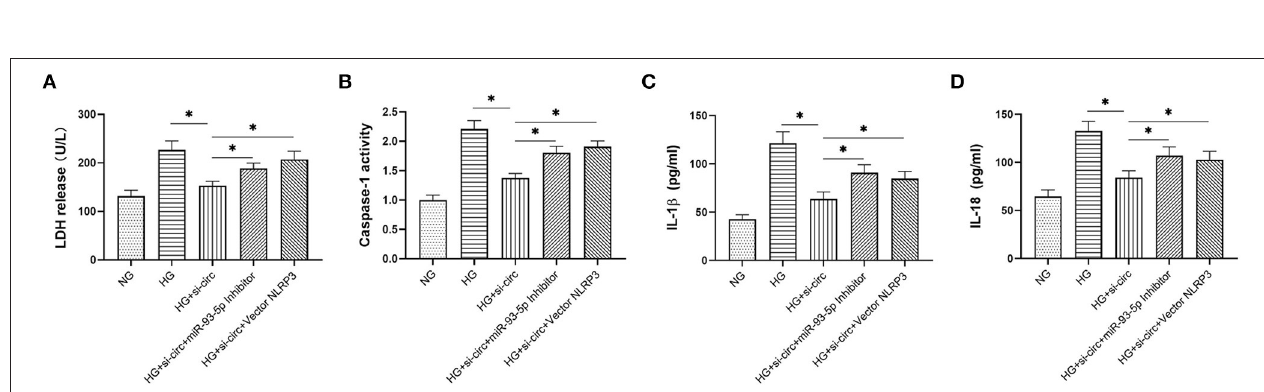
FIGURE 5 | The circ_0004951/miR-93-5p/ NLRP3 axis regulates HG-induced pyroptosis in HK2. LDH release in each group (A) . Caspase-1 activity in each group (B) . ELISA results showing expression levels of IL-1 β and IL-18 in each group (C,D) . HG, high glucose; HK2, human renal tubular epithelial cell line; LDH, lactate dehydrogenase. Values are expressed as mean ± SD. * p < 0.05 vs. control.